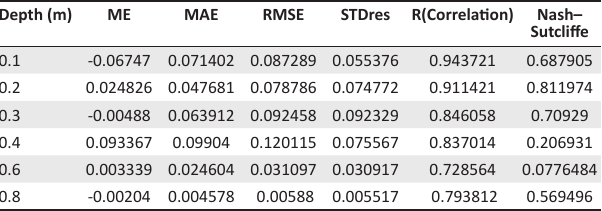
TABLE 3: Computed statistical values of model performance.